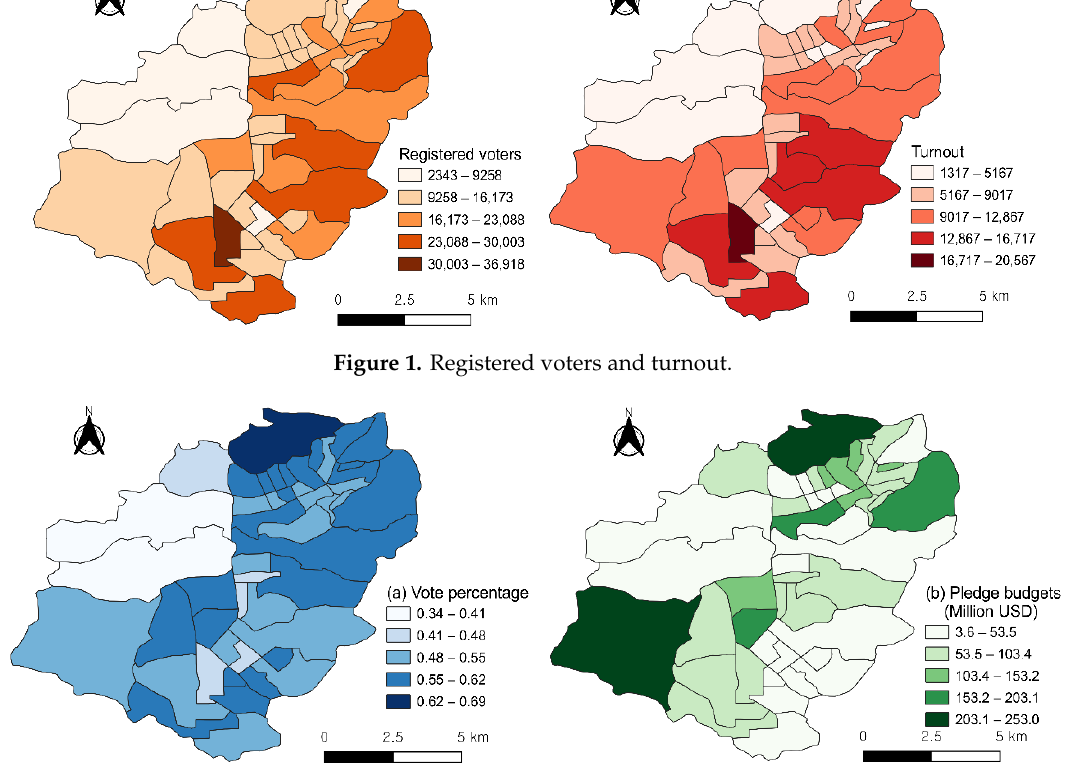
Figure 2. ( a ) Vote percentage and ( b ) pledge budgets.